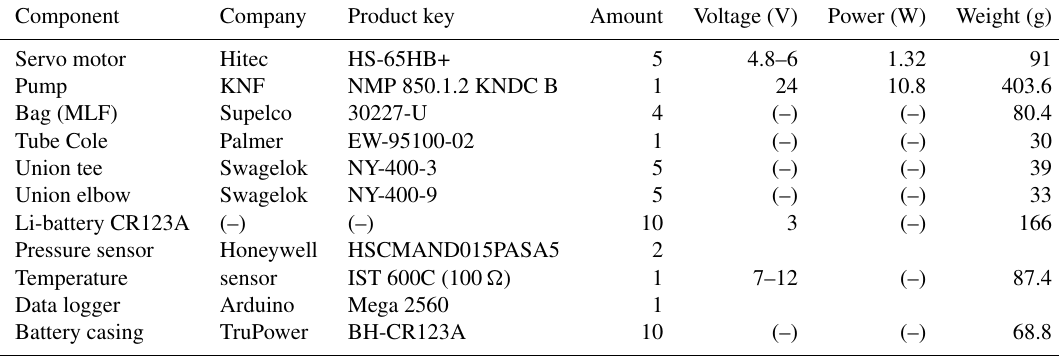
Table 1. Components used in the LISA sampler, including manufacturer and product key. The total weight is given for amounts per part. Voltage and power are presented according to manufacturer specification. The total weight for the onboard computer and sensors is given.